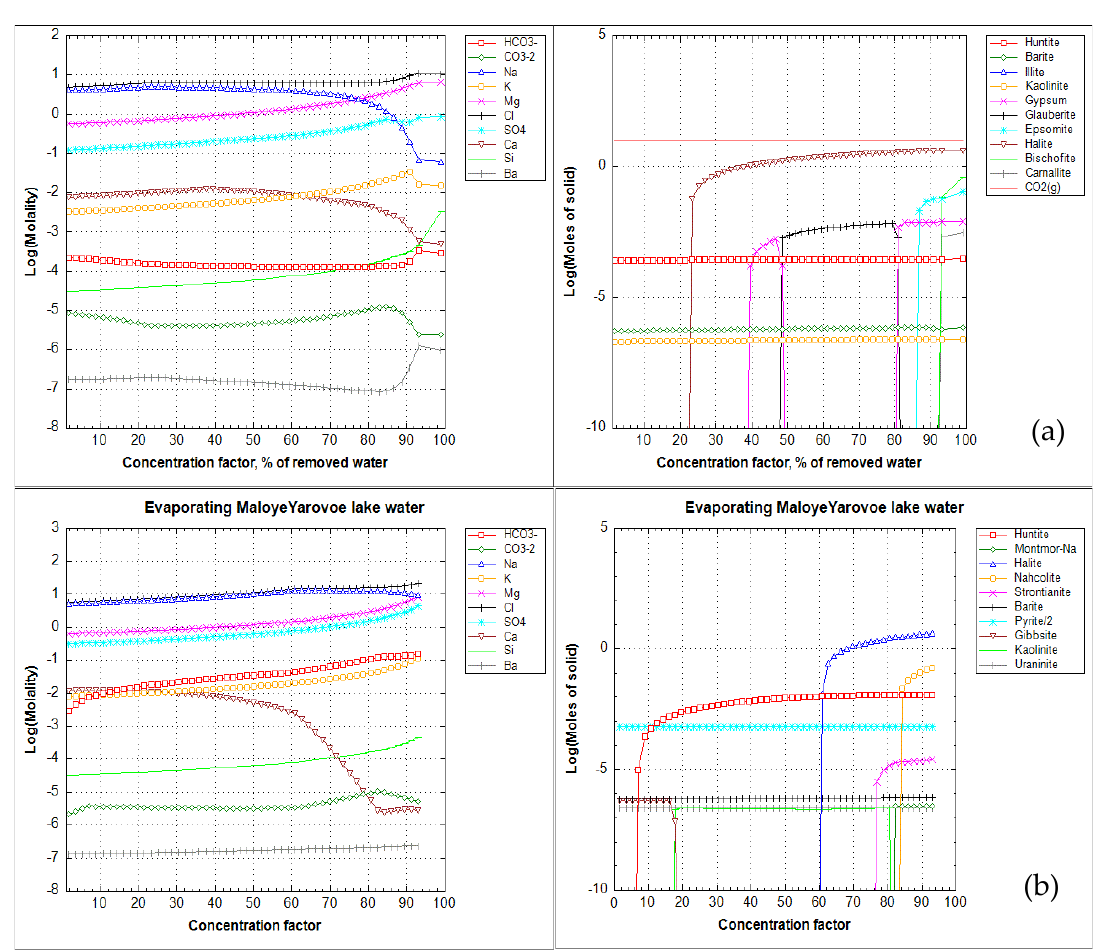
Figure 11. Evaporation trends of lake water chemical composition and mineral assemblages in oxicconditions (upper panel- a ) and in reducing condition and presence of organic matter (lower panel- b ).